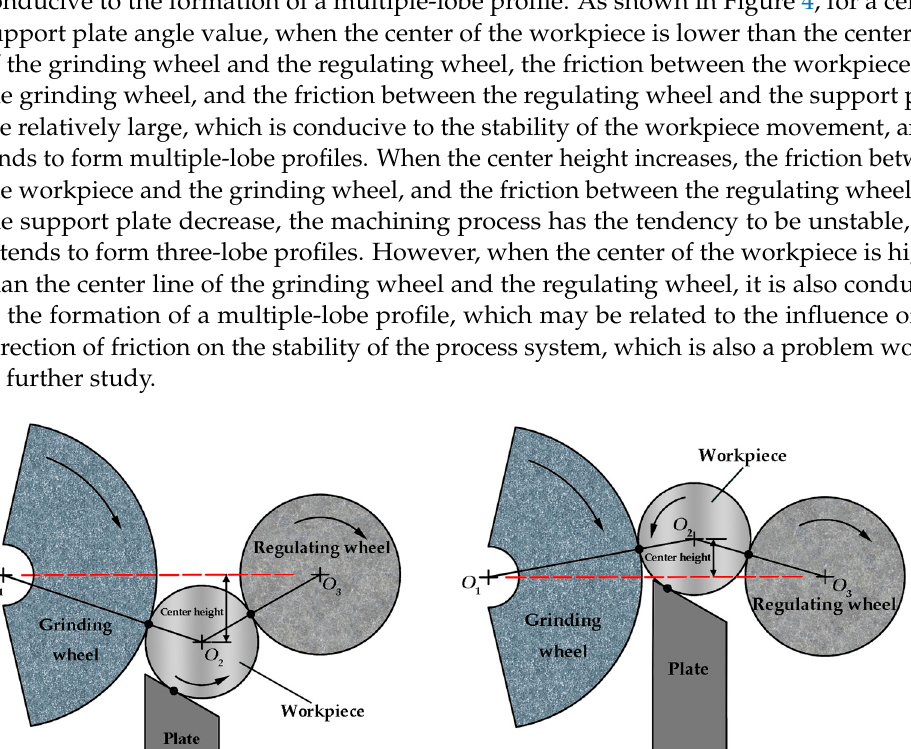
Table 5. Profile shapes before and after processing at different support plate angles and center heights.